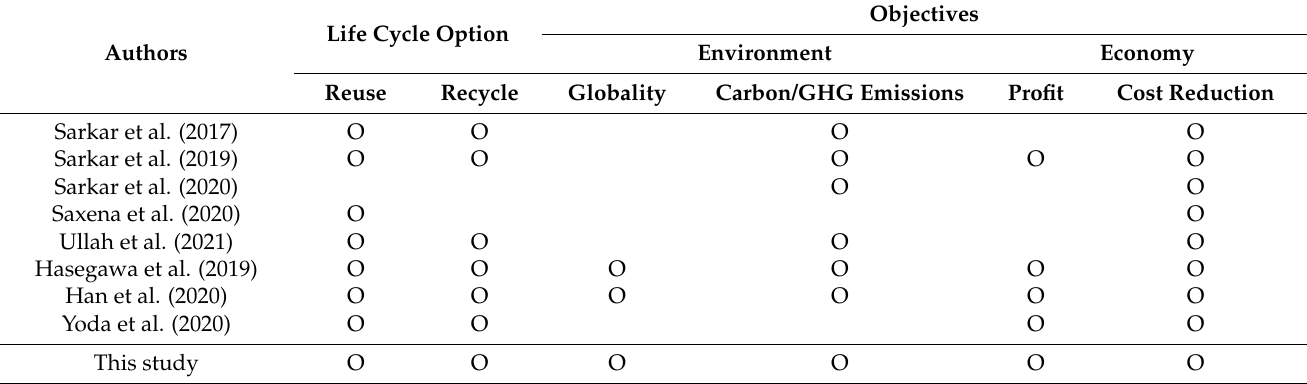
Table 1. Literatures on life cycle option by considering objectives for environmentally-friendly and economy.